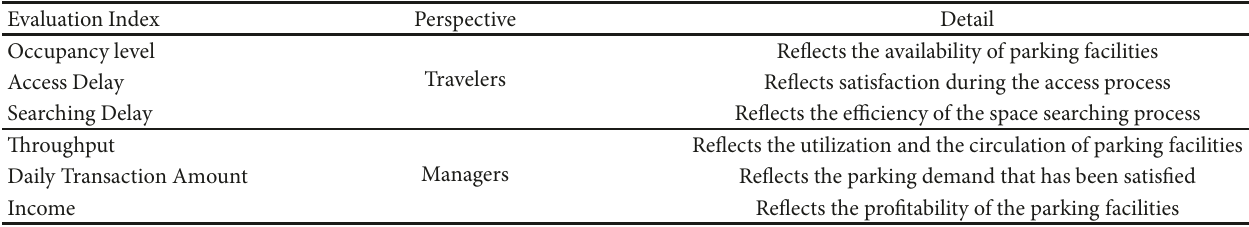
Table 2: Indexes for evaluating the impacts of the new parking price